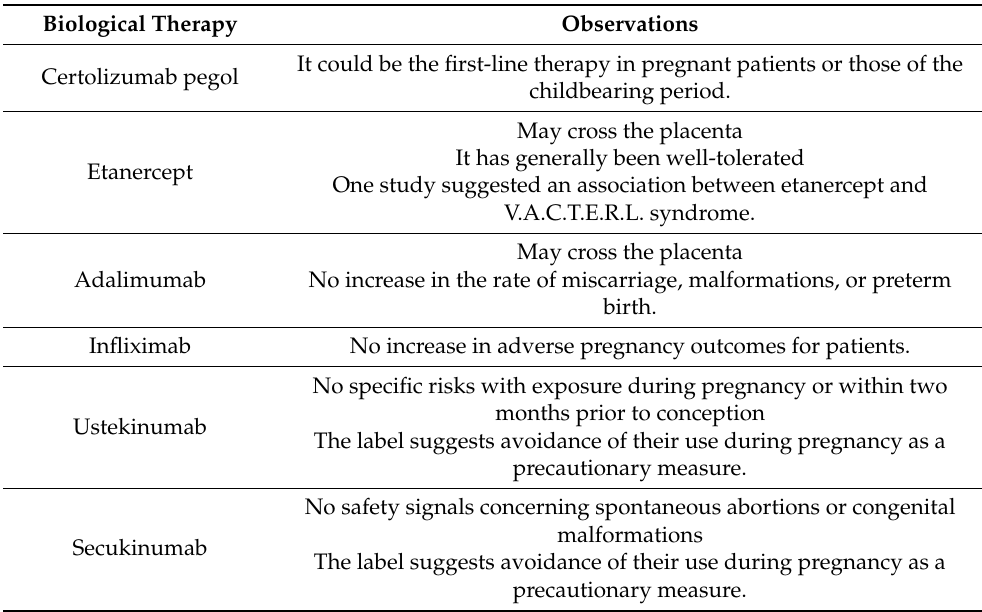
Table 5. Biological treatments in psoriasis associated pregnancy [111,112,114,120,123–126]. Biological Therapy